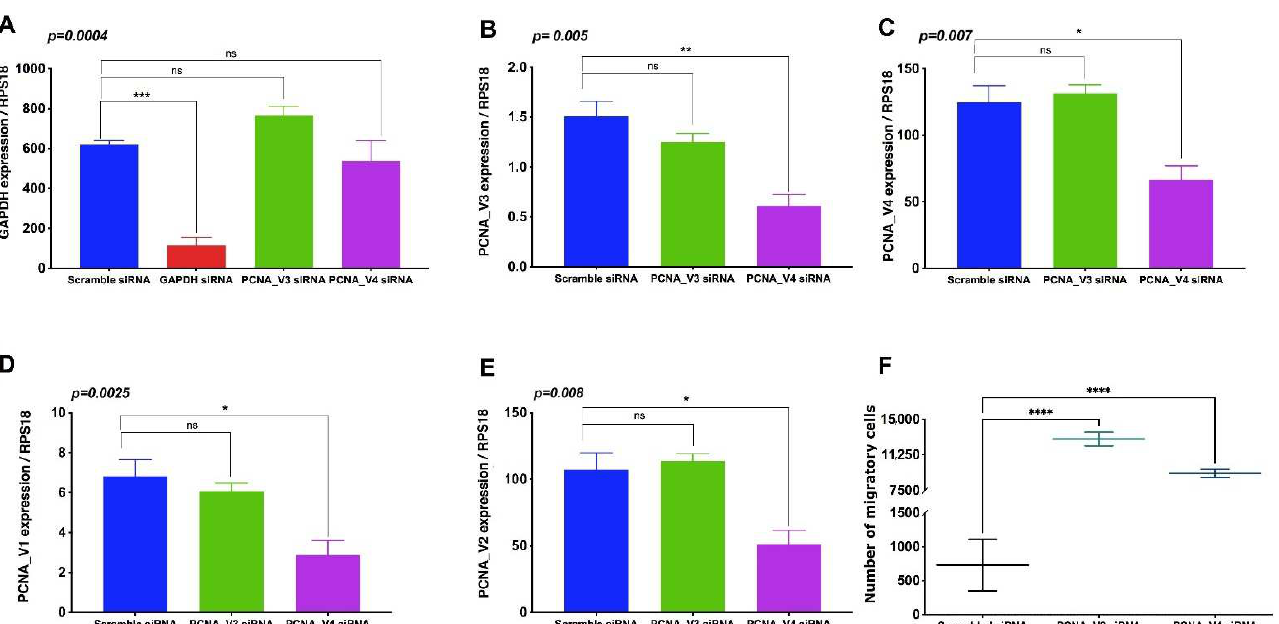
Figure 7. Bar graphs depict the mRNA silencing of the PCNA transcript variants and cells. The plot shows the absolute mRNA quantification using digital droplet RT‒PCR. The interference model included scramble siRNA (blue box), positive control siRNA (GAPDH, red box), PCNA_V3 siRNA (green box) and PCNA_V4 siRNA (purple box). ( A ) The graph shows the quantification of GAPDH expression, and we observed significant silencing of the positive control GAPDH. We did not observe changes in expression in the scramble, PCNA_V3 and V4 siRNA groups. ( B ) Quantification of PCNA_V3 expression. The graph shows a 25% decrease in the level of expression vs. scramble; however, surprisingly, PCNA_V4 decreased its level of expression by ~60%. ( C ) Quantification of PCNA_V4 expression. The plot showed significant inhibition of PCNA_V4, as expected. However, in PCNA_V3, no changes in expression levels were observed. ( D ) Quantification of PCNA_V1 ex- pression. We observed a subtle decrease in the level of PCNA_V3 siRNA expression and significant silencing by PCNA_V4 siRNA. ( E ) Quantification of PCNA_V2 expression. The plot showed signifi- cant silencing by PCNA_V4 siRNA; however, there were no differences by PCNA_V3 siRNA. ( F ) In the plot showing the transwell migration assay, we observed a significant increase in the number of migrating cells in the two siRNAs (PCNA_V3 and PCNA_V4). One-way ANOVA followed by Dunnett’s post-hoc test was considered statistically significant **** p < 0.0001, *** p < 0.001, ** p <